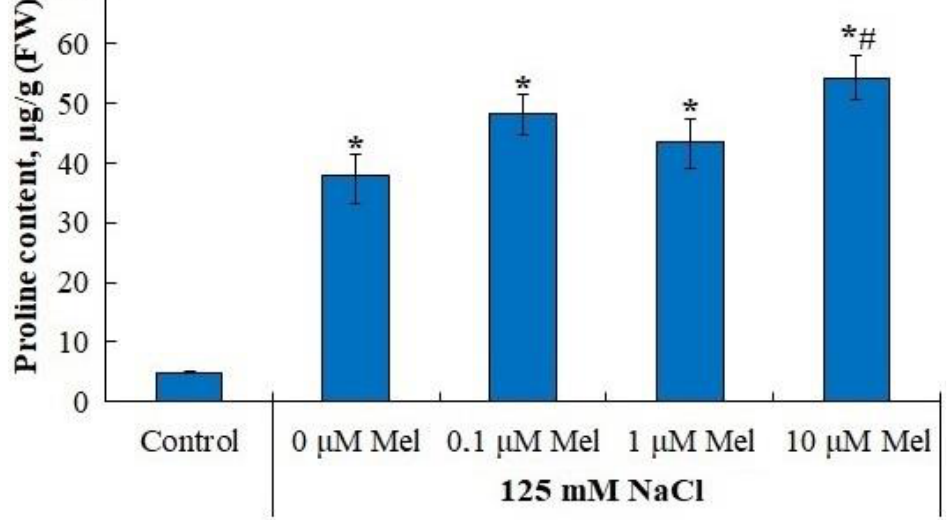
Figure 7. Influence of melatonin and chloride salinity on proline content in Solanum tuberosum leaves. Asterisks (*) indicate significant differences from the control variant and the «#» indicates significant differences from the«125 mM NaCl» variant ( p < 0.05).